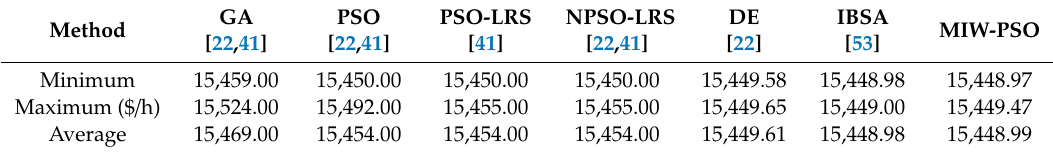
Table 10. Total generation cost comparison on the third case study.